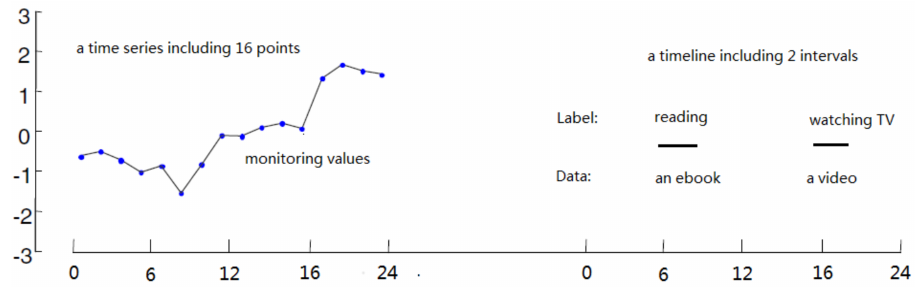
Figure 1. The difference between a timeline and a time series.